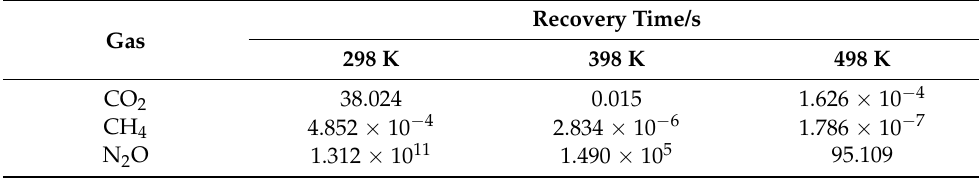
Table 3. Recovery time of gas at different